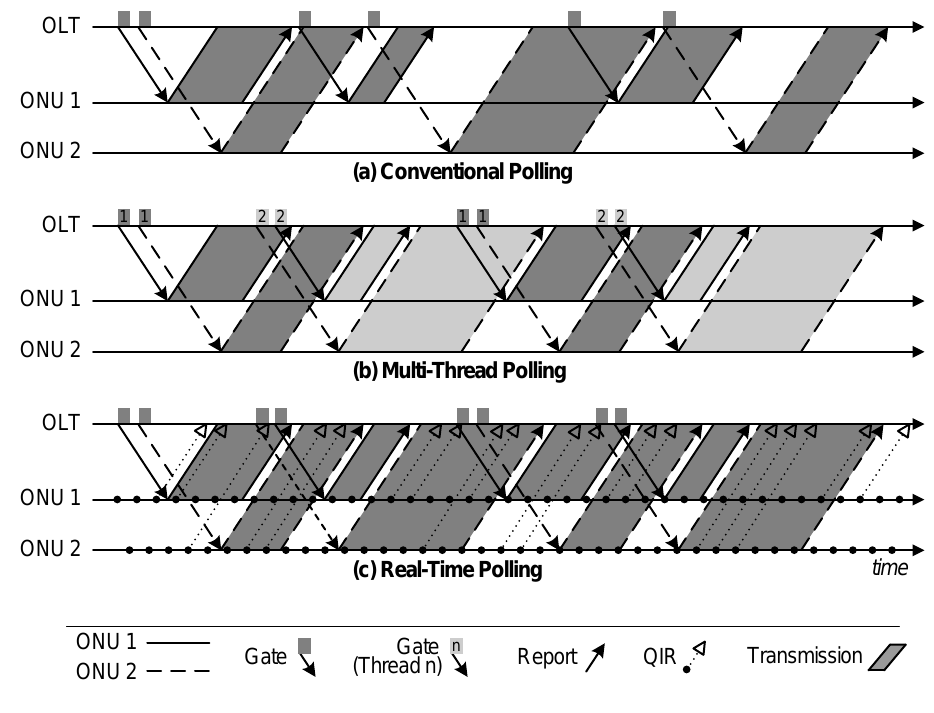
Figure 5. Conventional and low-latency polling